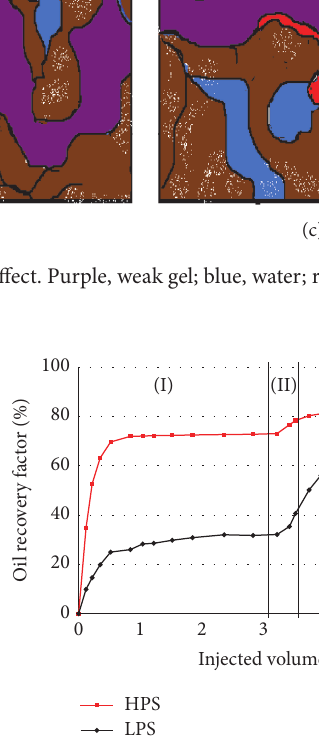
Figure 7: Oil recovery factor curves ((I) water injection, (II) weak gel injection, and (III) water